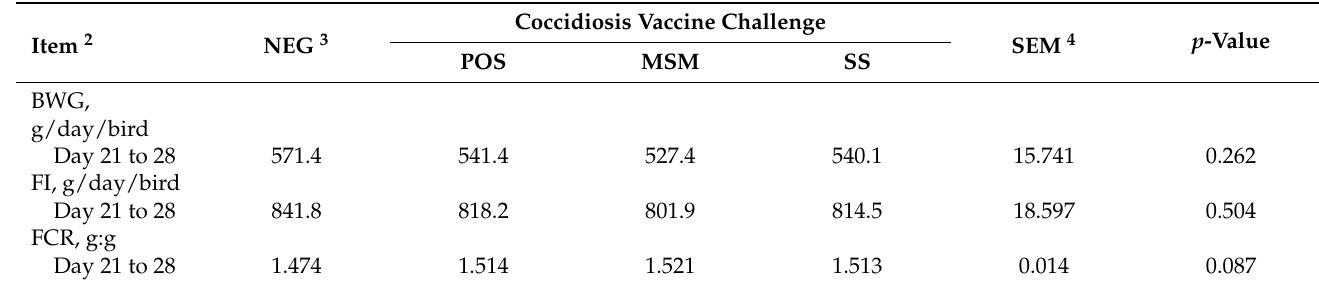
Table 4. Effect of dietary sulfur sources on growth performance in coccidiosis vaccine-challenged broiler chickens 1 .